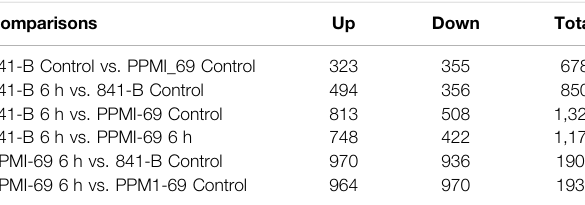
TABLE 3 | Statistics related to the number of signi fi cantly enriched differentially expressed genes (DEGs). Comparisons Up